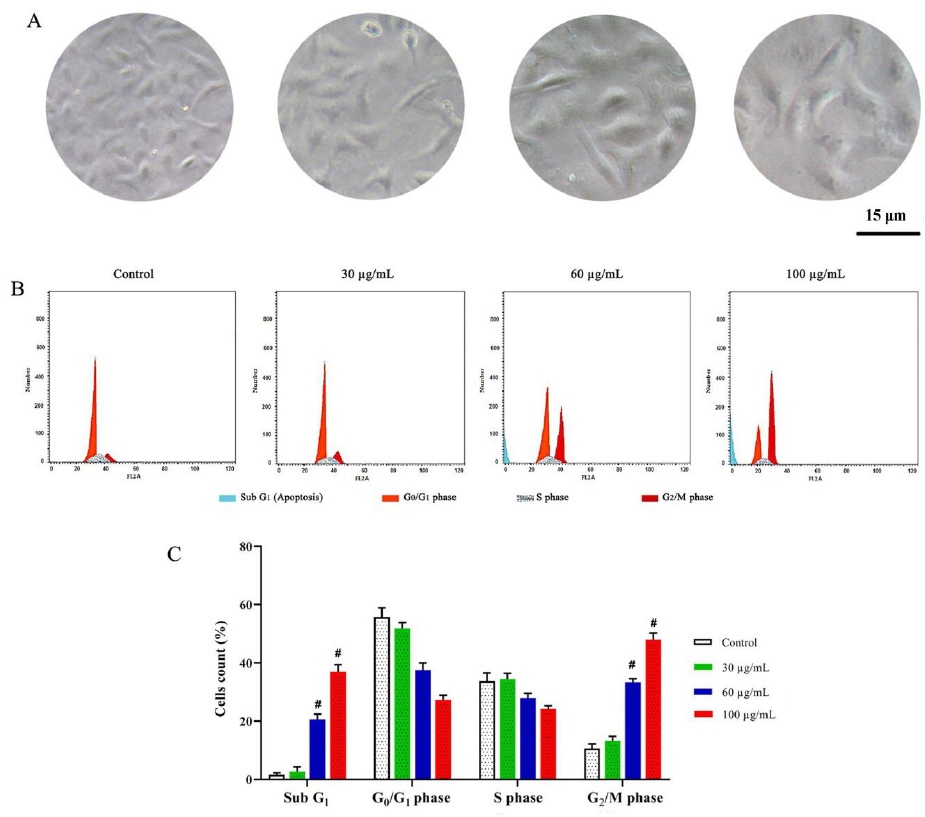
Figure 3. Effect of different M domestica hemolymph concentrations, 4 h post-curcumin injection ( A ), on the cell cycle distribution of treated and control MCF-7 cells. The cell cycle phases were analyzed according to DNA contents after propidium iodide (PI) labeling ( n = 3), ( B ). Data were illustrated as mean ± SD, # shows the significant increase with respect to the control ( p < 0.05), ( C ).